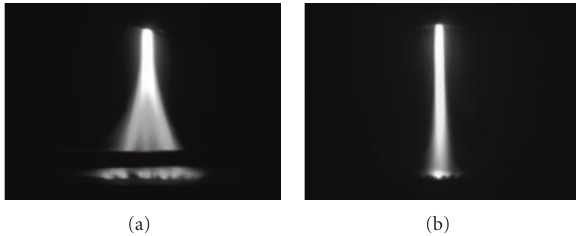
Figure 11: Arc driven by a sinusoidal AC magnetic field: front view (a) and side view (b).